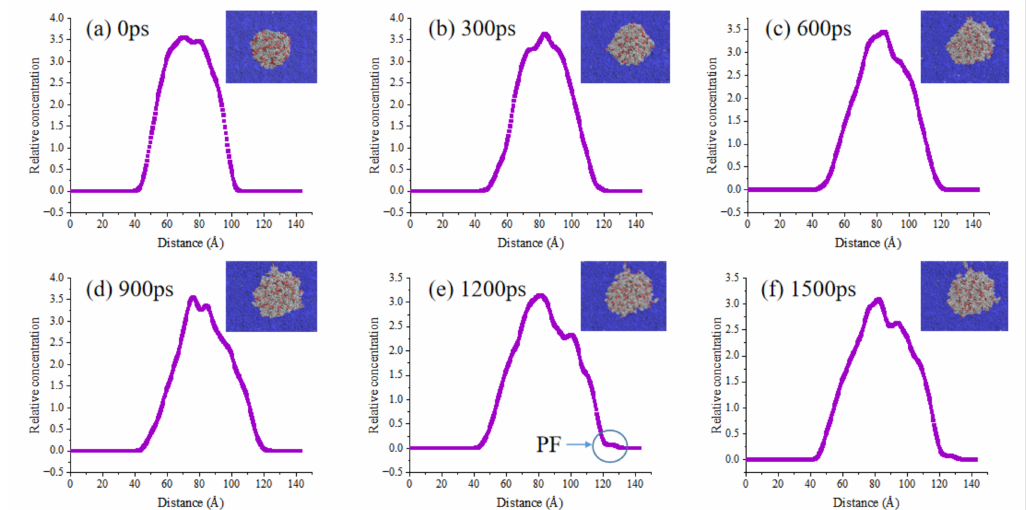
Figure 12. Side and top views of WWO droplet structure evolution. Note: blue block represents bitumen subgrade, purple line represents WWO droplet concentration profile.